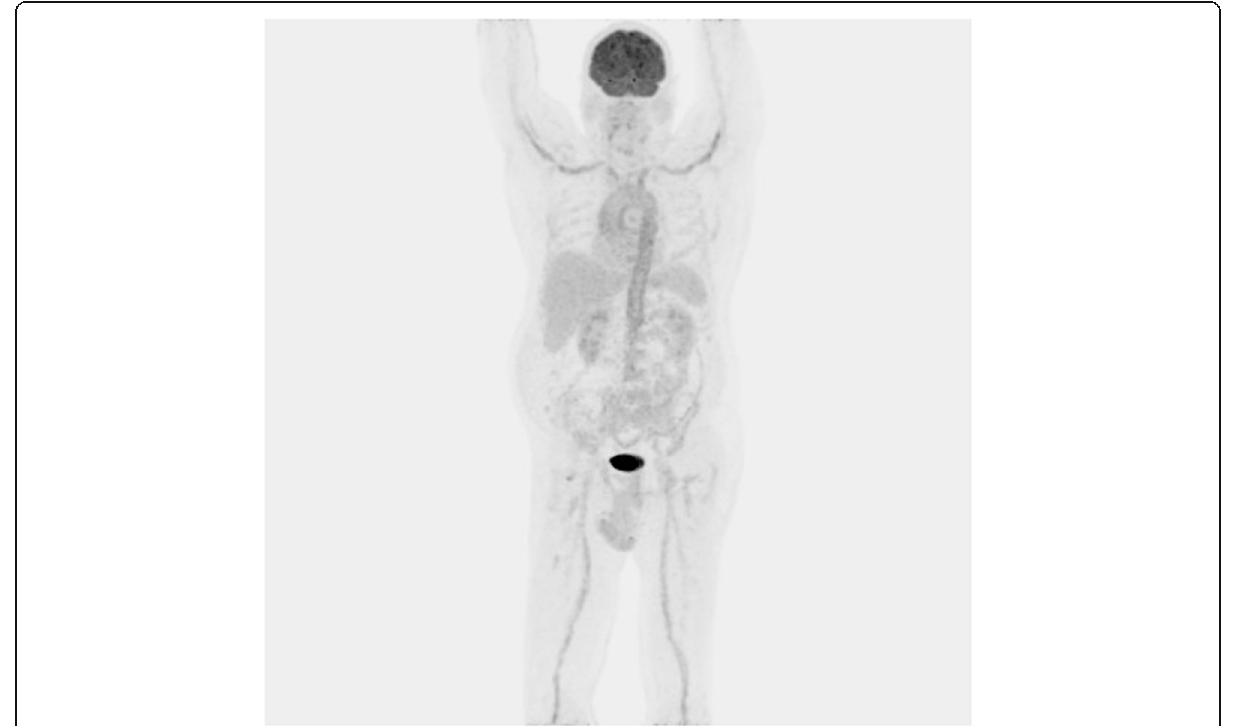
Fig. 4 Whole body FDG-PET image illustrating increased metabolic activity in the aorta wall as well as some of its main branches including both axillary